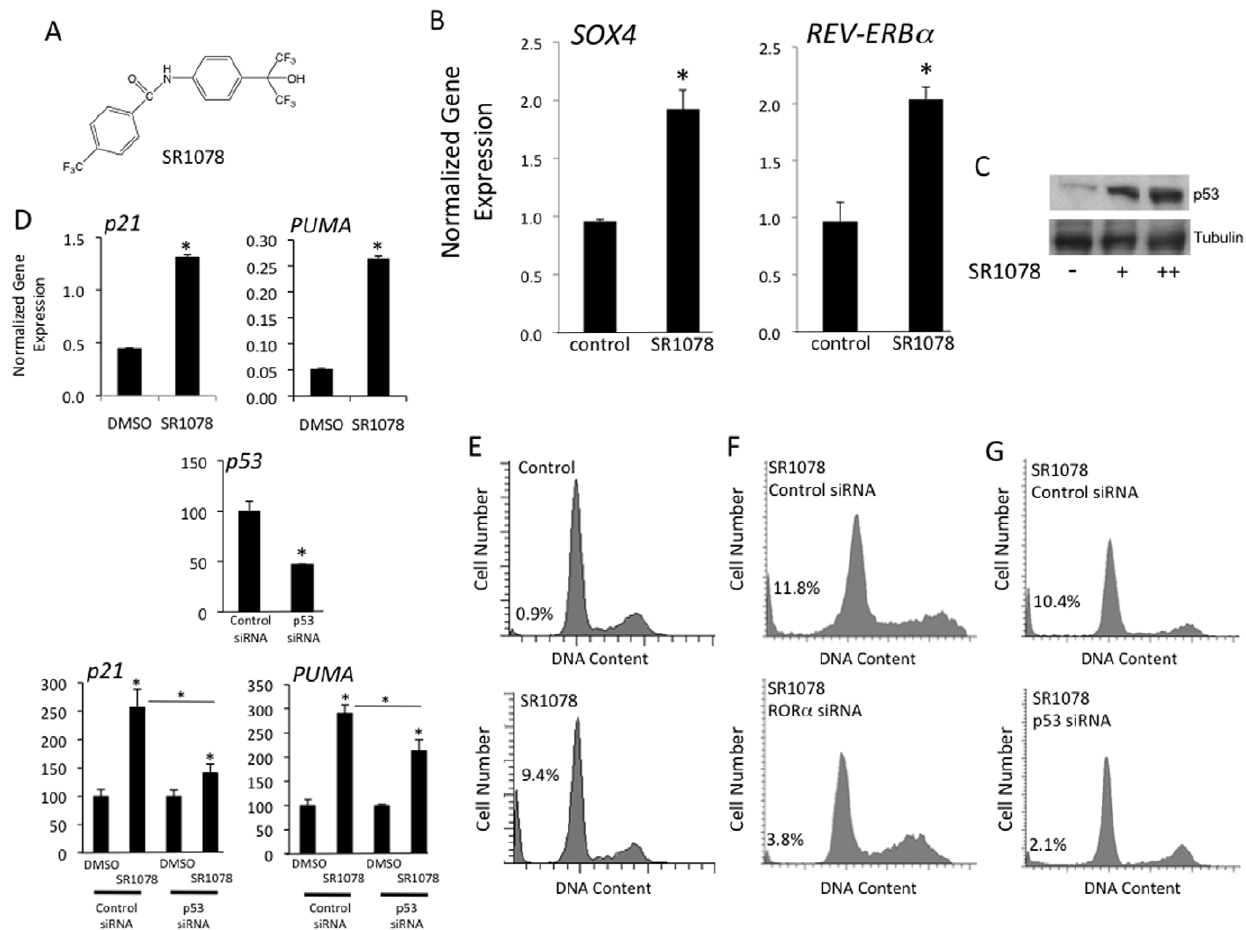
Figure 3. The ROR a agonist, SR1078, increases SOX4 expression and p53 function. A) Chemical structure of SR1078. B) Treatment of HepG2 cells with SR1078 leads to an increase in SOX4 and REV-ERB a mRNA expression. C) Treatment of HepG2 cells with SR1078 leads to increased p53 protein levels. + indicates 1 m M and ++ indicates 5 m M SR1078. D) Treatment of HepG2 cells with SR1078 leads to increased expression of p53 target genes, p21 and PUMA . Experiments shown in the lower panels were performed identical to the upper panels with the exception of inclusion of siRNA treatments as indicated. E) Cell cycle analysis of control HepG2 cells treated with vehicle control or SR1078. Note the substantial increase in cells in sub-G 1 following SR1078 treatment, 0.9% vs 9.4% indicated on the graph. F) Cell cycle analysis of HepG2 cells treated with either control siRNA or ROR a siRNA in the presence of vehicle control or SR1078. G) Cell cycle analysis of HepG2 cells treated with either control siRNA or p53 siRNA in the presence of vehicle control or SR1078. *, indicates p , 0.05.